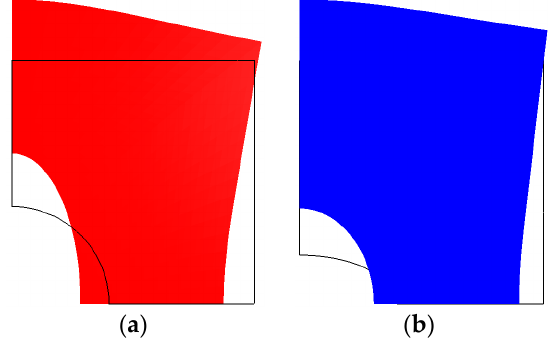
Figure 1. Distributions of total displacements around a hole for isotropic plates determined by finite element analysis: ( a ) circular; ( b ) horizontal ellipse (the scaling factor is 5, i.e., the computed values are multiplied by the factor 5).